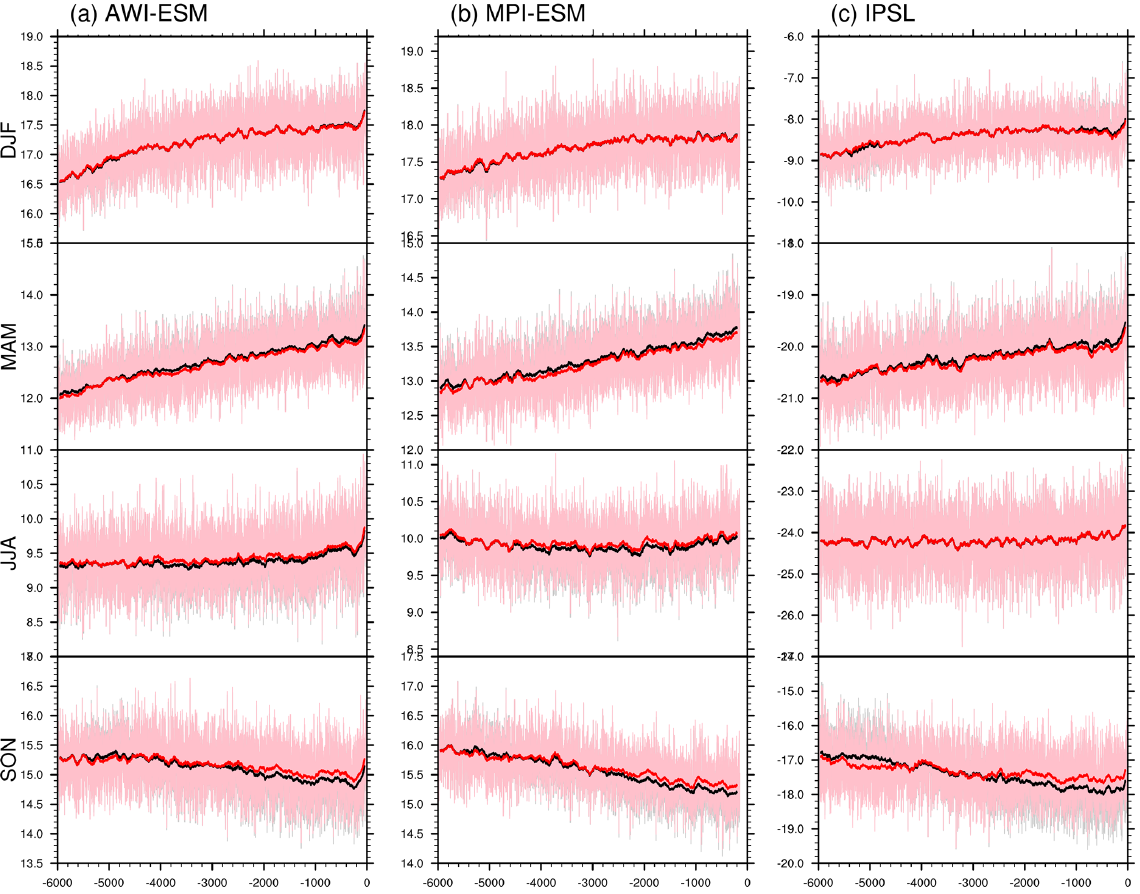
Figure 14. Time series of surface air temperature in classical and angular means averaged over Southern Hemisphere continents, weighted by month length, for (a) AWI-ESM, (b) MPI-ESM, and (c) IPSL-CM. Grey and pink lines stand for the original classical and angular means respectively. Smoothed curves with a running window of 100 model years are shown in black (for classical means) and red (for angular means). Units: ◦